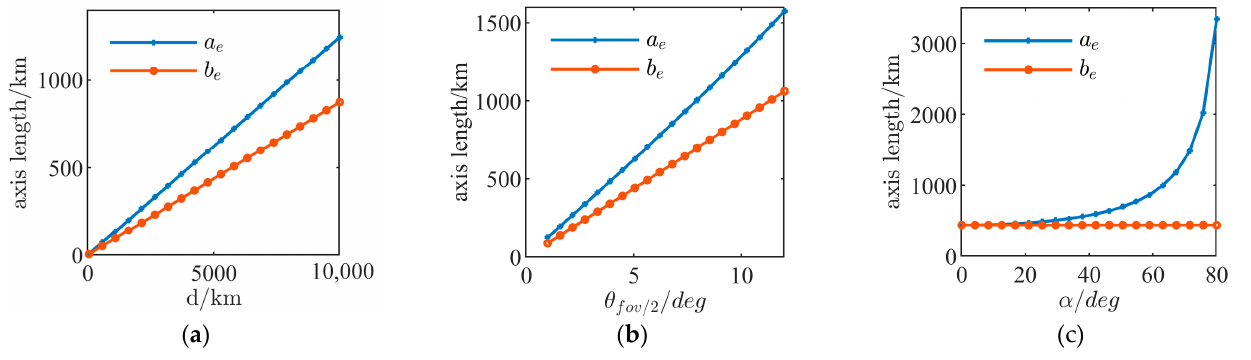
a b and e : ( a ) curves with the increase in the detection θ ; and ( c ) curves with the increase in